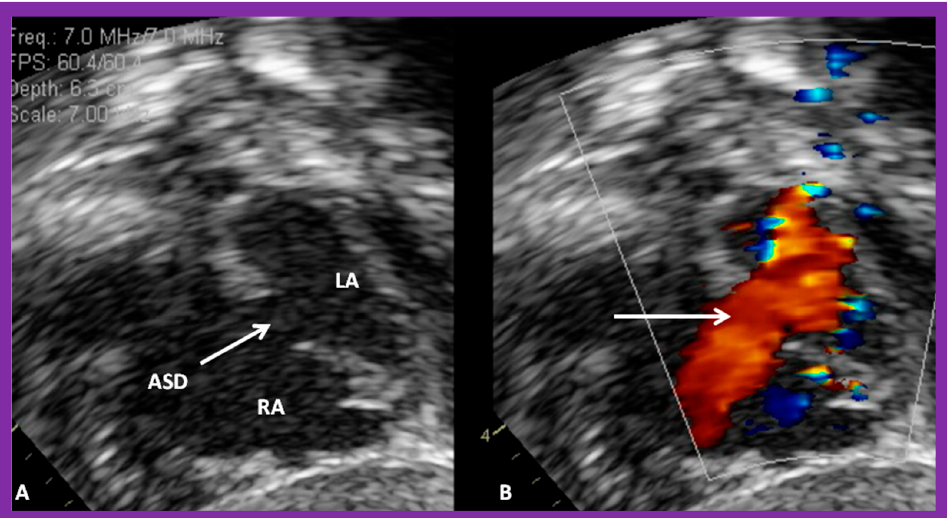
Figure 4. 2D echocardiogram ( A ) and color flow imaging ( B ) in subcostal short-axis view, demonstrating an atrial septal defect (ASD) (arrow in ( A )) with a left-to-right shunt (arrow in ( B )). Left atrium (LA) and right atrium (RA) are shown. Reproduced from Reference [6].